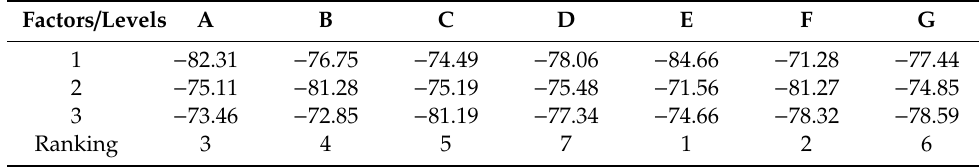
Figure 5. Main effect diagram for the average binding free energy value of degrading enzyme and Figure 5. Main e ff ect diagram for the average binding free energy value of degrading enzyme and TCPP–OH based on L 27 (3 7 ) Taguchi experimental design. TCPP–OH based on L 27 (3 7 ) Taguchi experimental design. Table 8. Ranking result for the external conditions of biodegradation of degrading enzyme and TCPP–OH molecule based on L 27 (3 7 ) Taguchi experiment